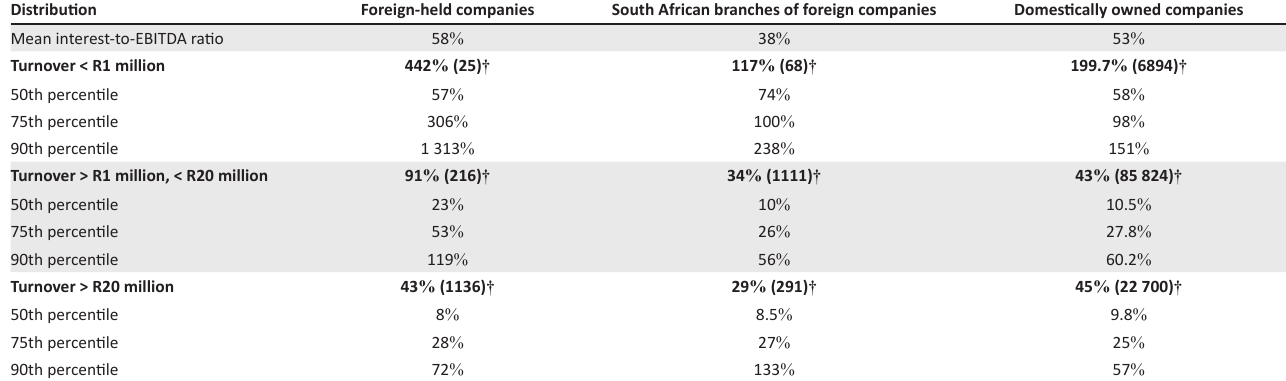
TABLE 4: Mean interest-to-EBITDA ratios according to entity size. Distribution